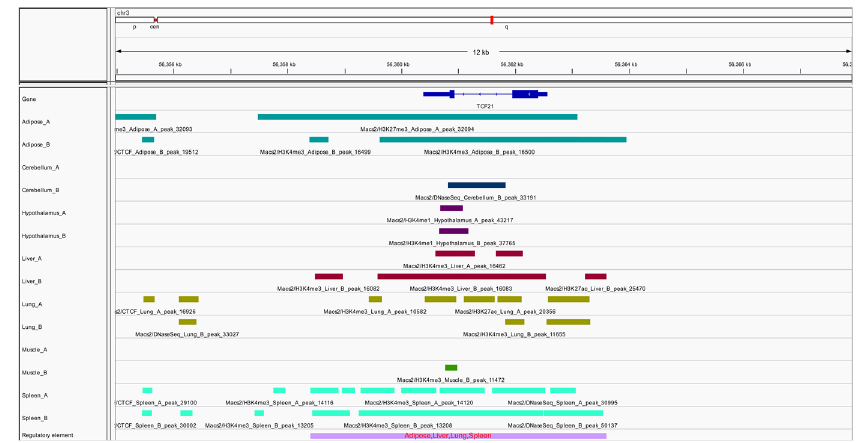
Figure 1. Bioinformatics analysis of the TCF21 gene in chickens. Table 2. The differences in allele frequencies of SNPs between the lean and fat